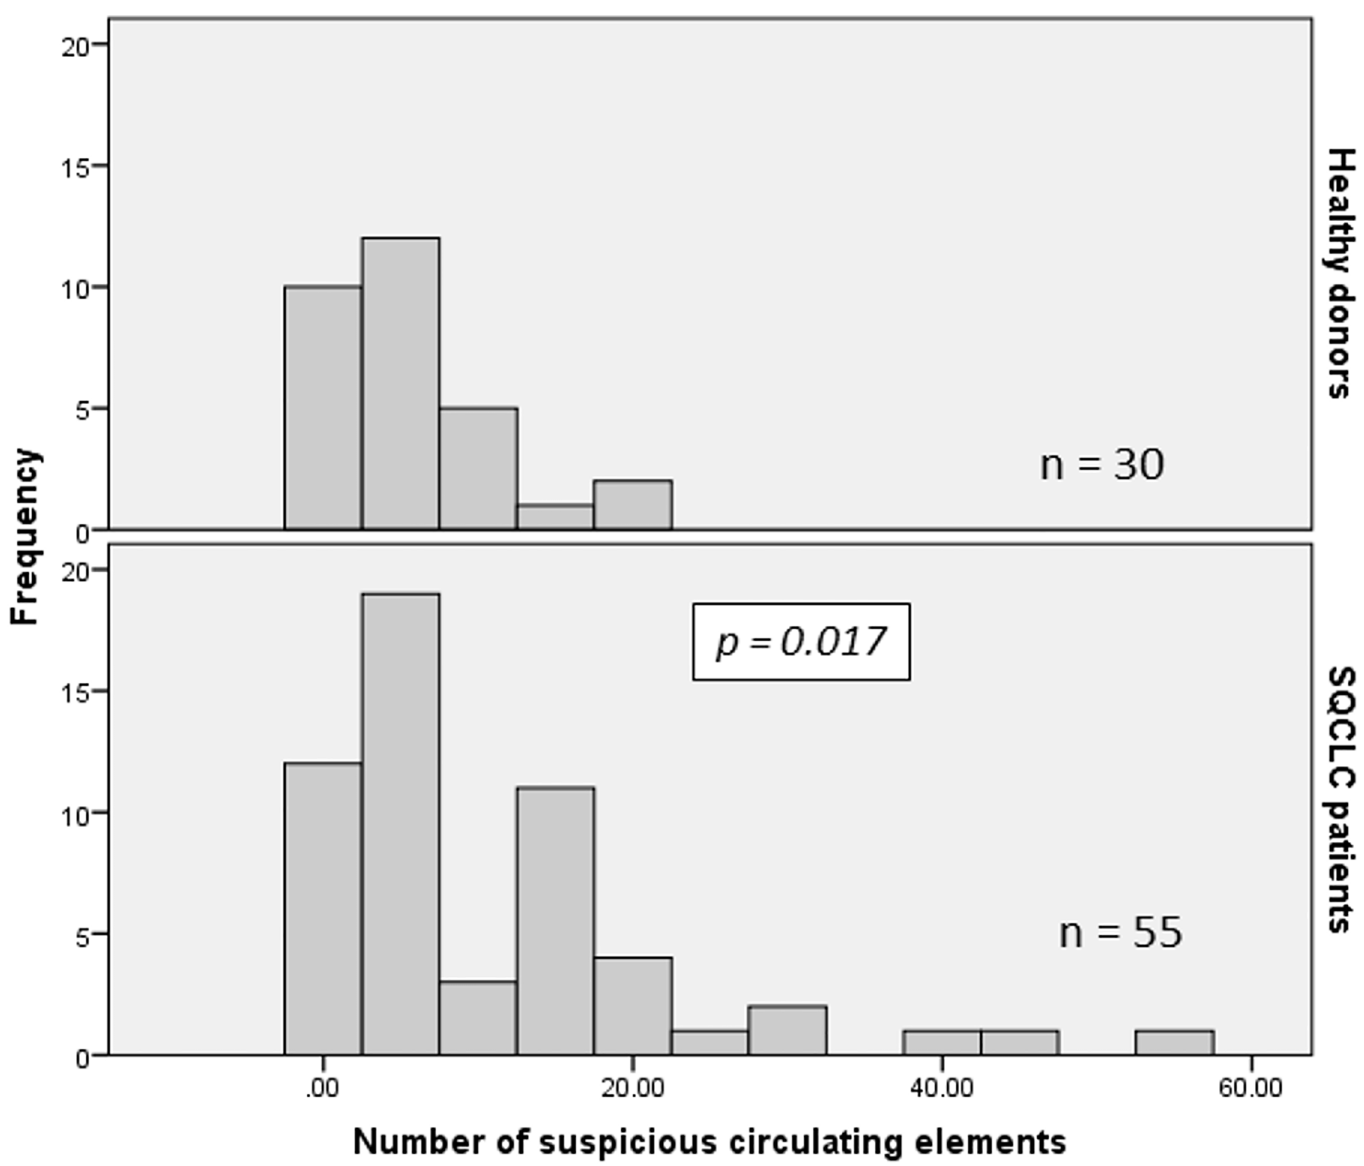
Fig 6. Distribution of suspicious circulating elements isolated by depletion procedure from SQCLC patients and healthy